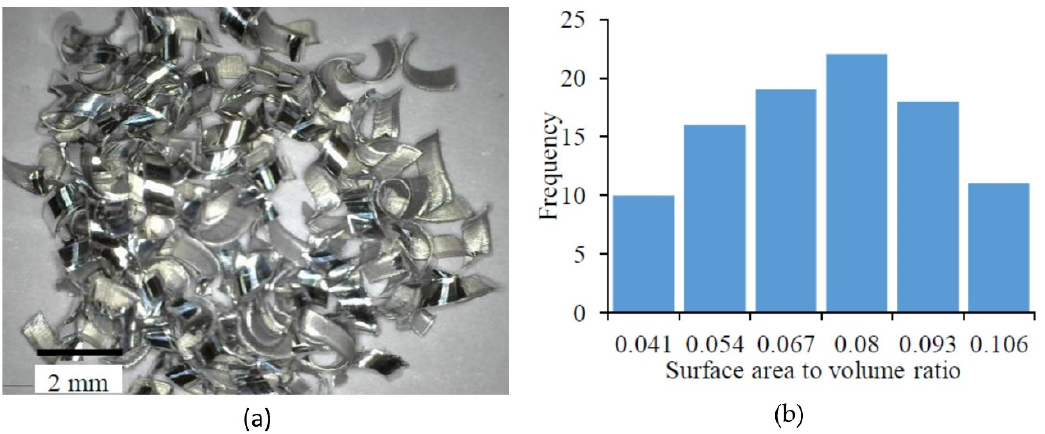
Figure 2. Aluminium chips; ( a ) chips shape; ( b ) chips total surface area to volume ratio.